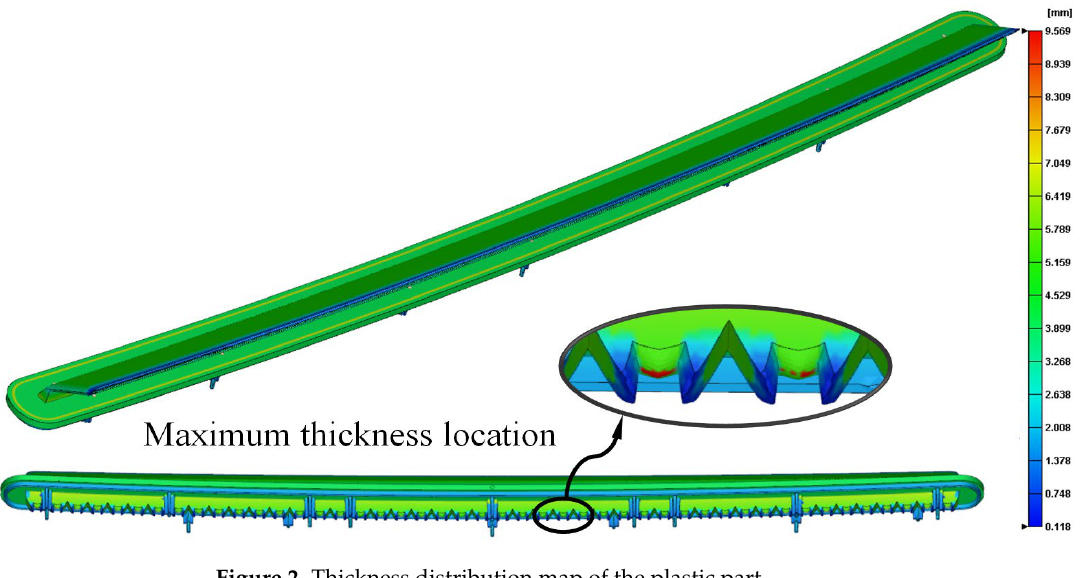
Figure 2. Thickness distribution map of the plastic part.